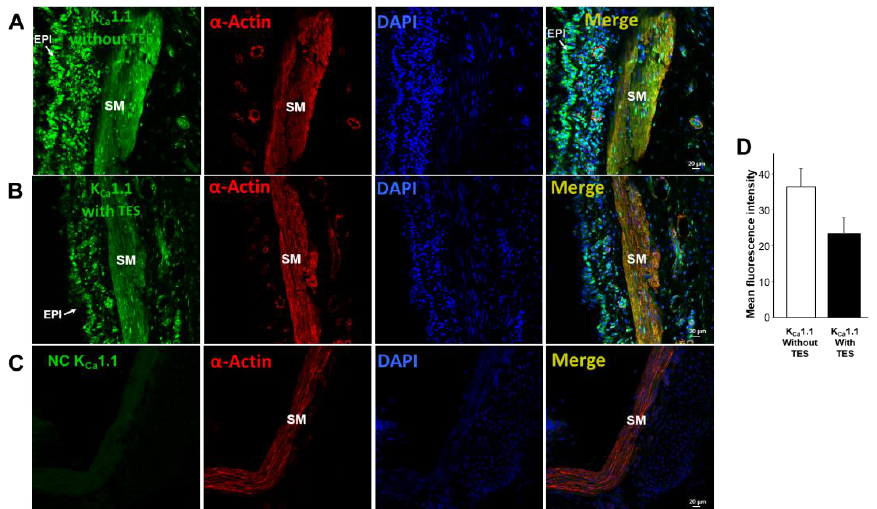
Figure 9. Testosterone fails to increase K Ca 1.1 levels in guinea pig airway smooth muscle. In the first column, K Ca 1.1 immunofluorescence (green color) is shown in guinea pig tracheal tissues without ( A ) and with ( B ) 40 nM TES incubation for 48 h. Note that in contrast to K V 1.2 and K V 1.5, no increase in fluorescence was observed when tissues were exposed to TES. ( C ) The absence of the primary antibody for K Ca 1.1 (BK Ca channel) showed no fluorescence (NC = negative control). The second column illustrates smooth muscle α -actin (red), and the third column depicts nuclei stained with DAPI (blue). Merged images of the first three panels are shown in the fourth column. The yellow color indicates the colocalization of K Ca 1.1 and α -actin. ( D ) Bar graph summarizes the quantification of K Ca 1.1 levels expressed as mean fluorescence, n = 5. S.E.M. is indicated by error bars. SM = smooth muscle, and EPI =